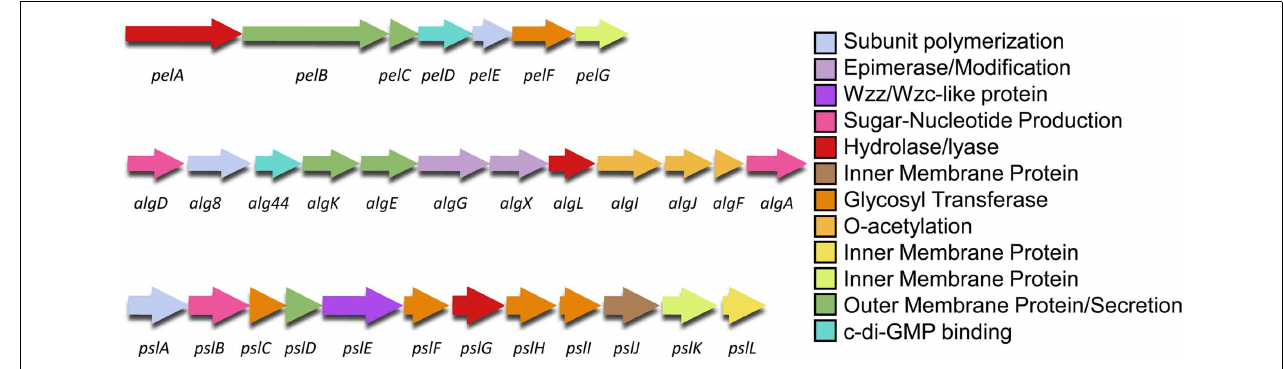
FIGURE 3 | Genetic structure of the Pel , alg , and Psl operons. The genes are color coded by proposed function as shown in Figures 4 – 6 .